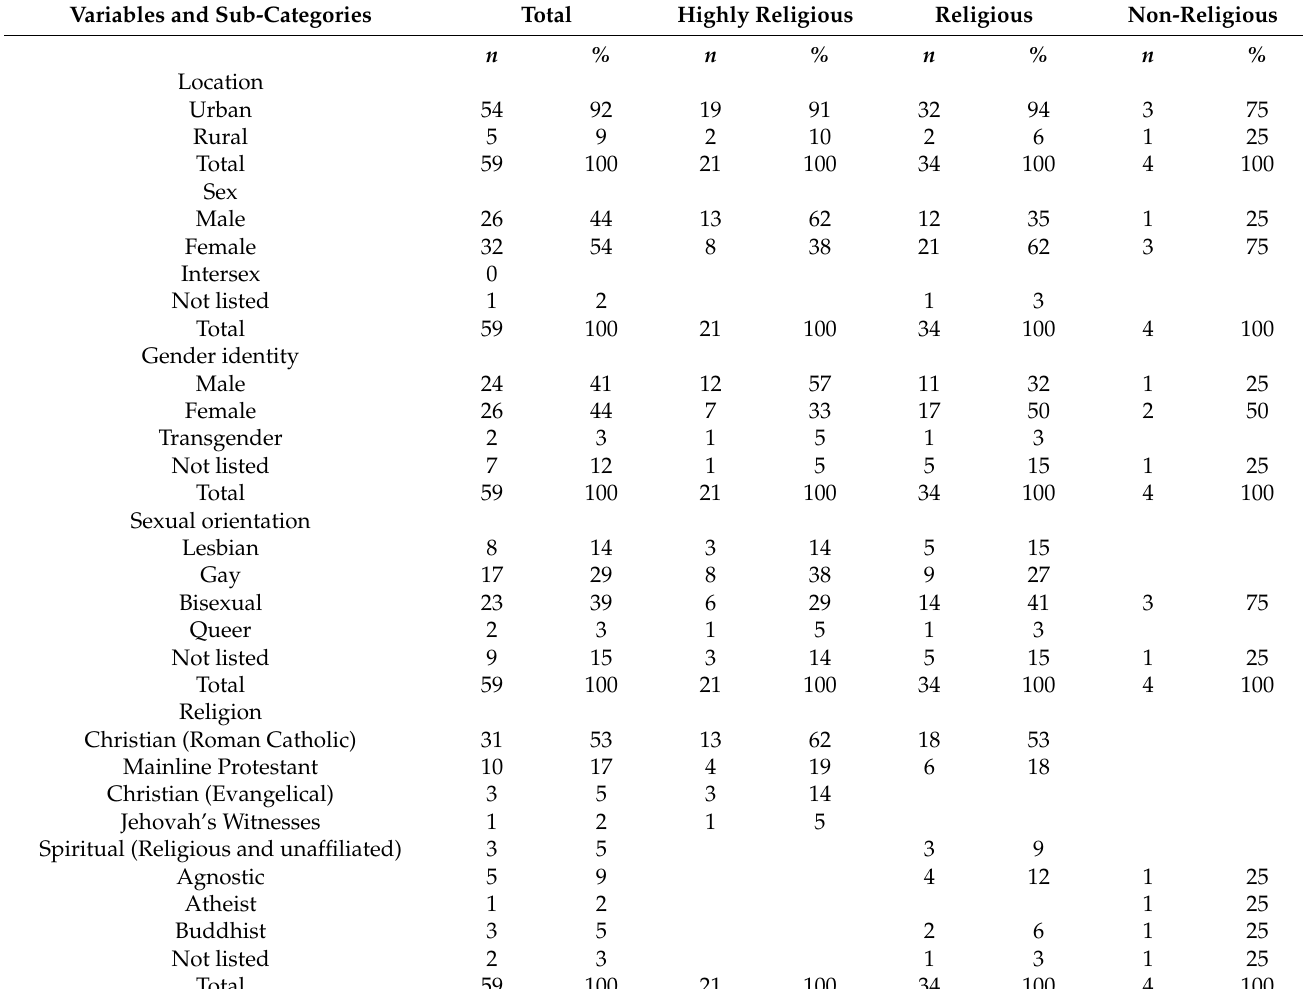
Table 1. Selected LGBTQ demographics and levels of